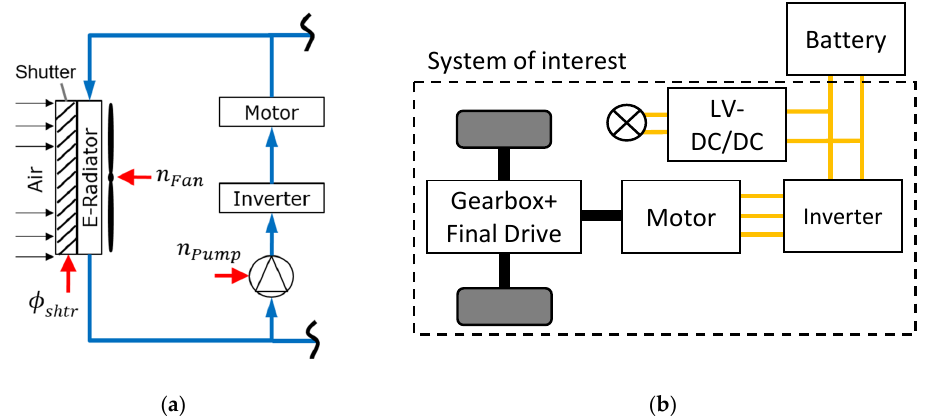
Figure 1. Overview of the system setup: ( a ) thermal system layout and control inputs; ( b ) electrical and mechanical layout of the powertrain.